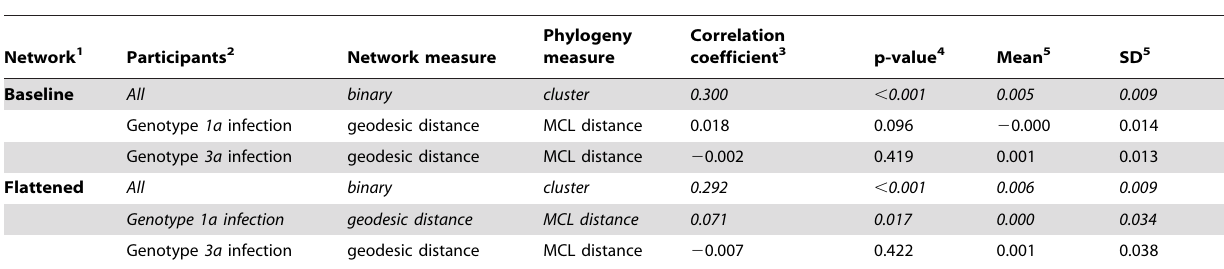
Table 3. Correlation between injecting networks and HCV